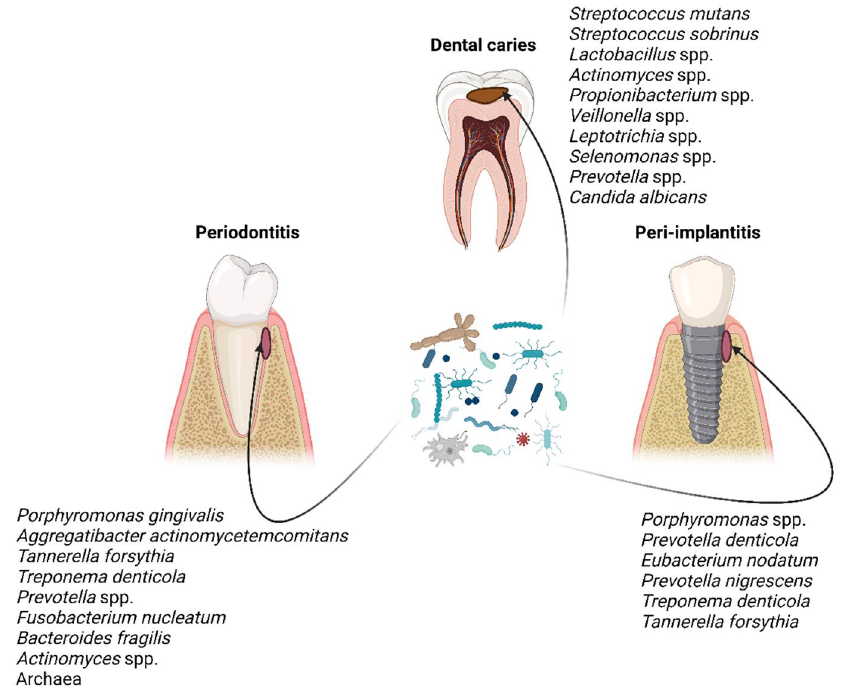
Figure 1. Characteristic taxa associated with dental caries, periodontitis, and peri-implantitis [30–35]. Figure created with BioRender.com.